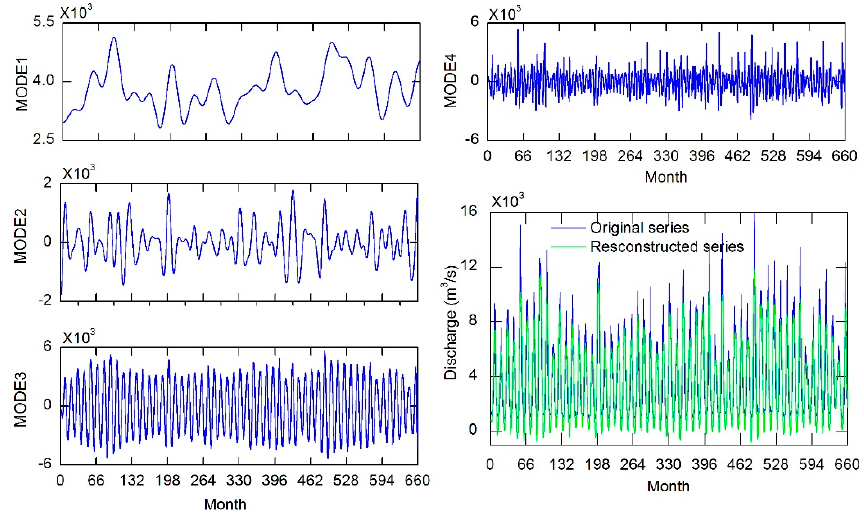
Figure 4. Visual representation of the decomposed subseries and the comparison between the original and reconstructed series.